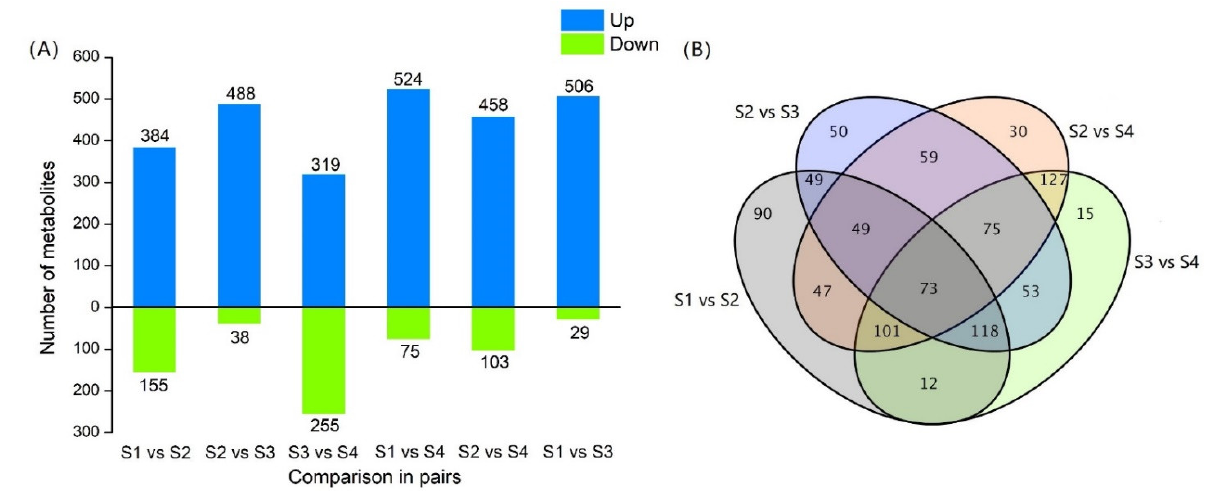
Figure 6. Identification of differentially accumulated metabolites among four development stages. ( A ) Number of different accumulated metabolites in at any two different developmental stages of B. juncea. ( B ) Venn diagram of differentially accumulated metabolites expressed commonly or distinctly in two or more comparisons .